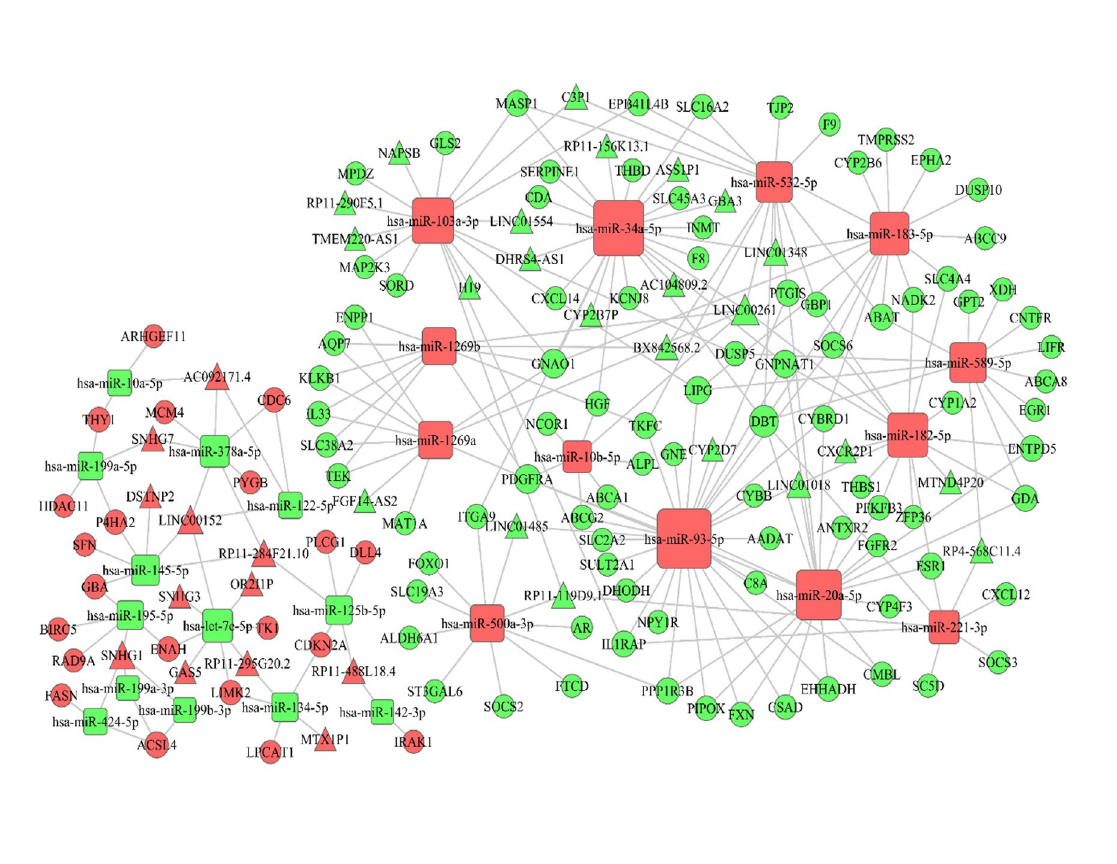
Fig 4. LncRNA-miRNA-mRNA network of DERNAs. Red stands for upregulated genes and green stands for downregulated genes. circles represent mRNAs, quadrates represent miRNAs, diamonds represent lncRNAs. The point size corresponds to regulatory ability of genes. Larger point means stronger regulatory